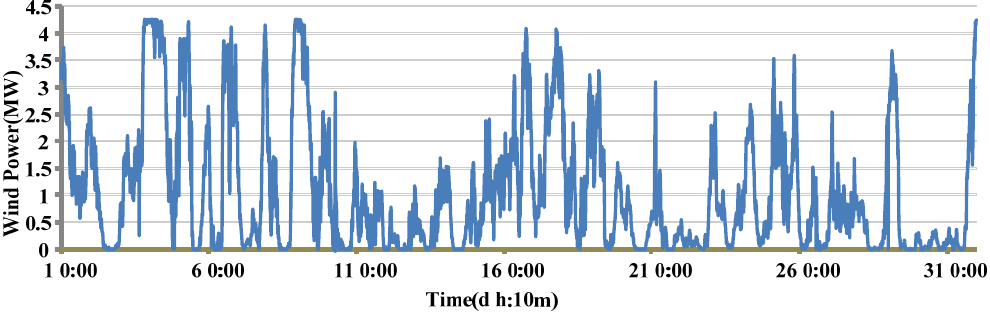
Figure 10. Wind power data in 31 days with 10 min intervals.